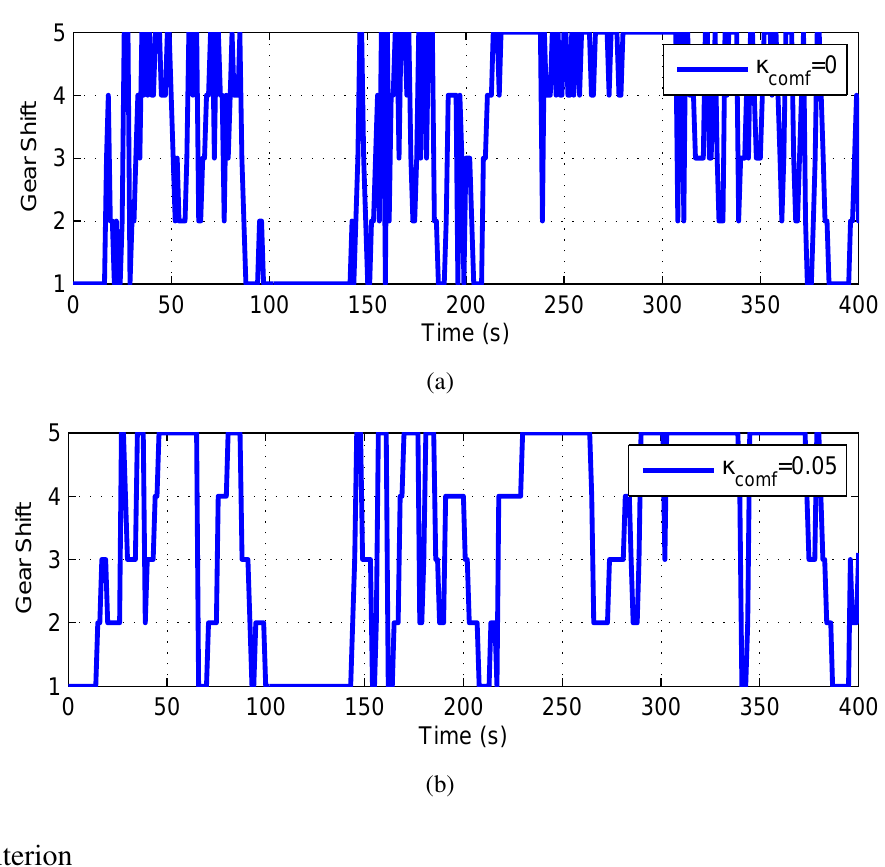
Figure 6. The effect of the drivability constraint on the engaged mode: ( a ) κ (cid:54) = 0 ( b ) κ comf